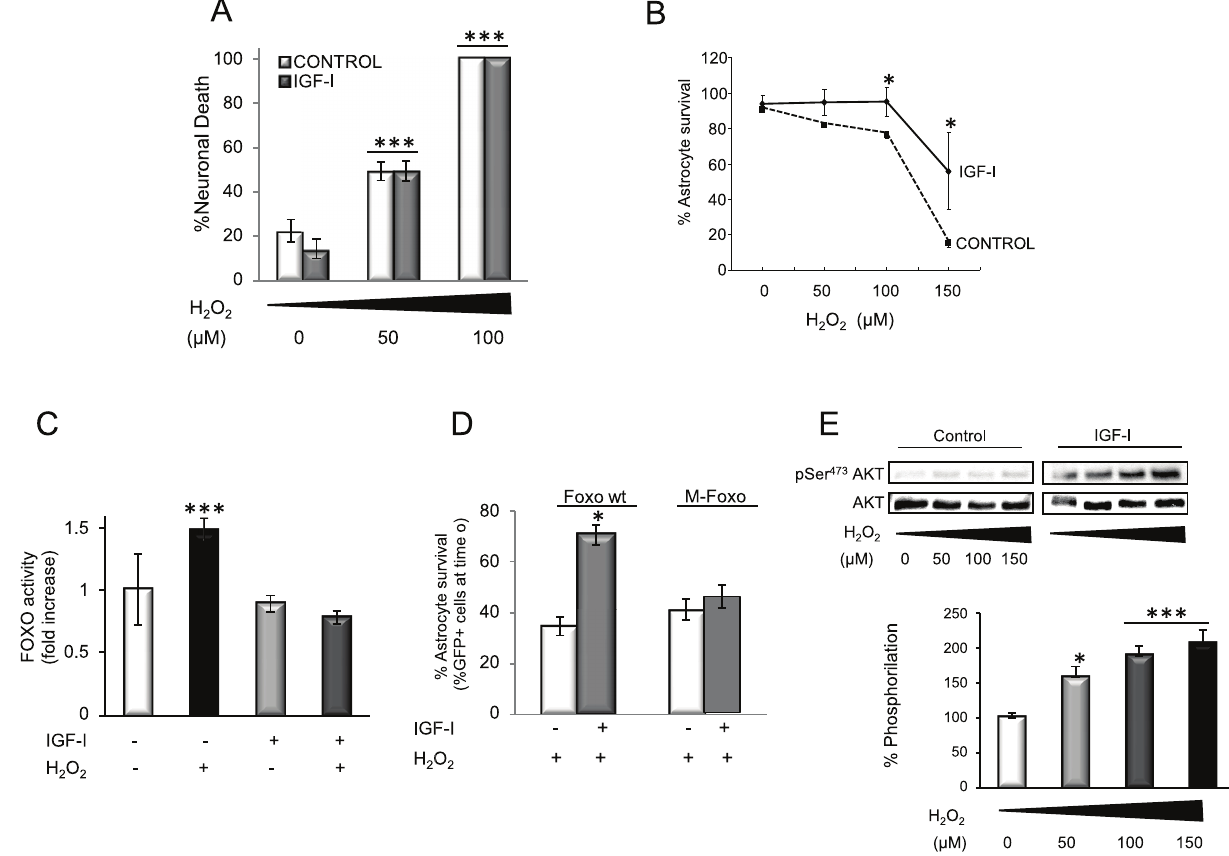
Figure 3. IGF-I protects astrocytes against oxidative stress. A ) Whereas IGF-I increases neuronal survival under control conditions, it does not protect neurons from